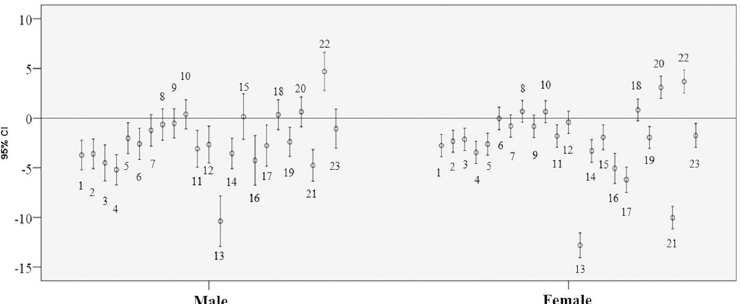
Fig 2. Bar chart of 95% confidence intervals of the mean difference between observed height and height estimated for elderly living in nursing homes stratified by sex, Brazil, 2014. (A) Numbers in the error bars correspond to the analyzed